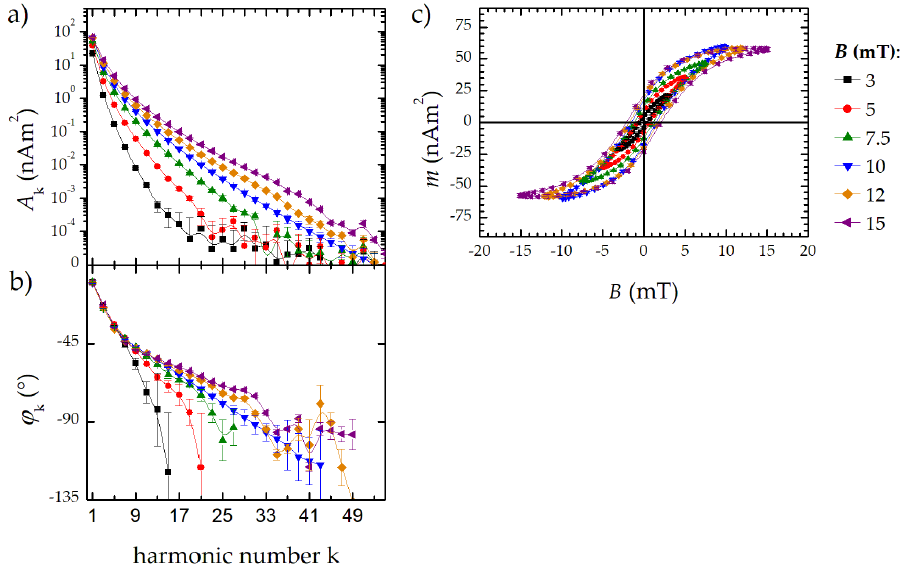
Figure 5. Field dependent MPS signal without A 1 filtering: ( a ) MPS amplitude signal; ( b ) MPS phase signal; ( c ) reconstructed M ( H ) curve. The displayed lines are guides to the eye.